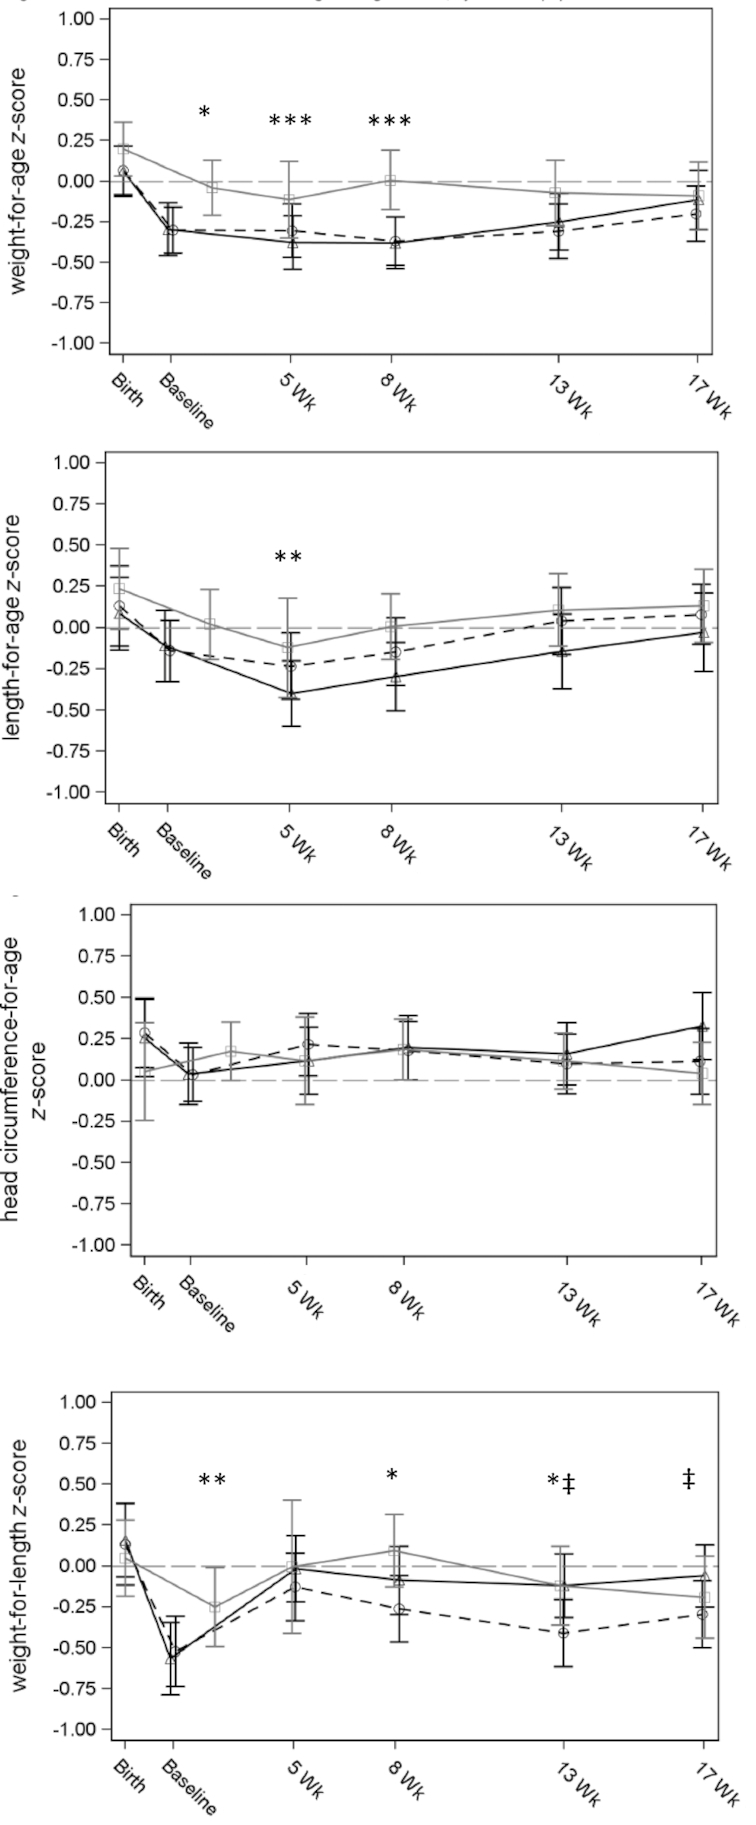
Mean (± 95% CI) weight-for-age, length-for-age (left and right upper panel), head-circumference-for-age, and weight-for-length (left and right lower panel) WHO growth standard z scores for the Control IMF (Δ, black solid line), Concept IMF (○, dashed black line), and the breastfed reference group (□, gray line) of the PP population. ‡Statistical difference between Concept and Control IMF (P < 0.05); *statistical difference between Concept IMF and breastfed group (P < 0.05); **statistical difference between Control IMF and breastfed group (P < 0.05); ***statistical difference between both IMF groups compared with breastfed group (P < 0.05). IMF, infant milk formula.